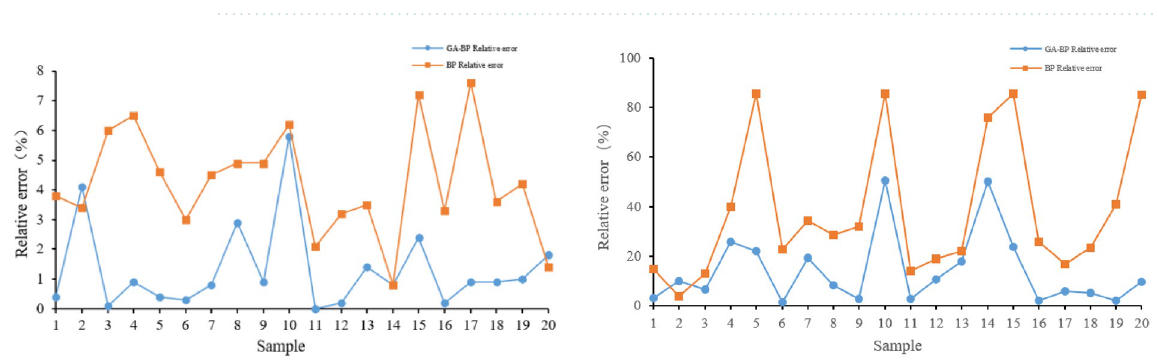
(a)Prediction results of vibration acceleration (b) Equipment lubrication prediction results Figure 3. Forecast results.